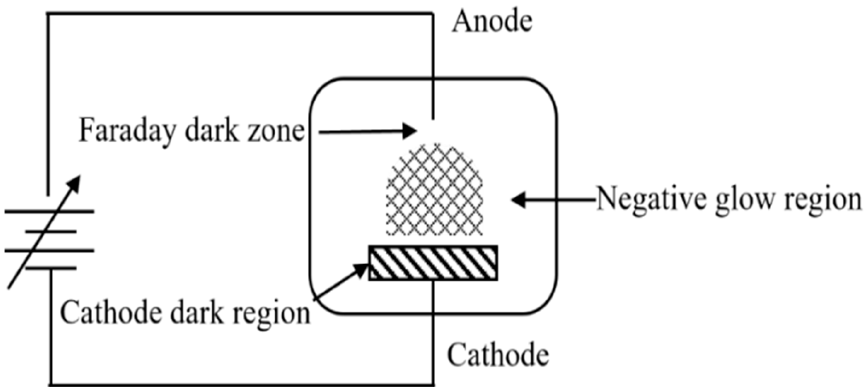
Figure 4. Schematic diagram of a low pressure glow